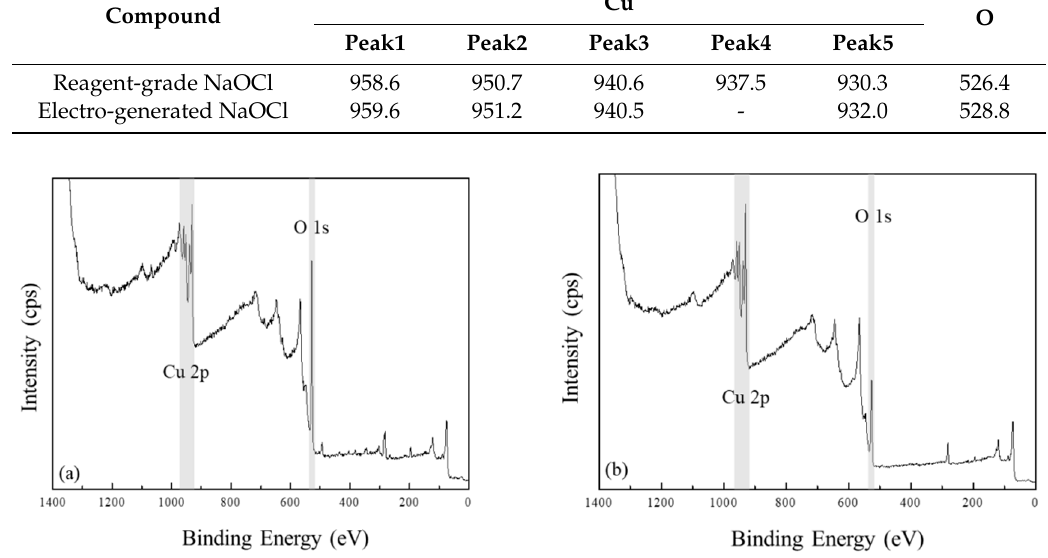
Figure 4. XPS spectra of the precipitated Cu ( a ) by reagent-grade hypochlorite and ( b ) by electro-generated hypochlorite.